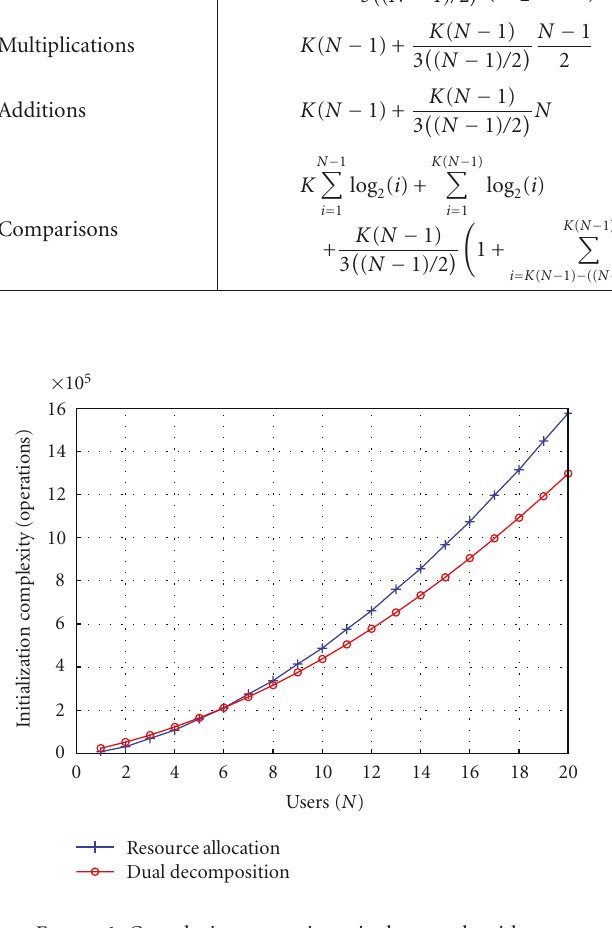
Figure 1: Complexity comparison single-user algorithms.